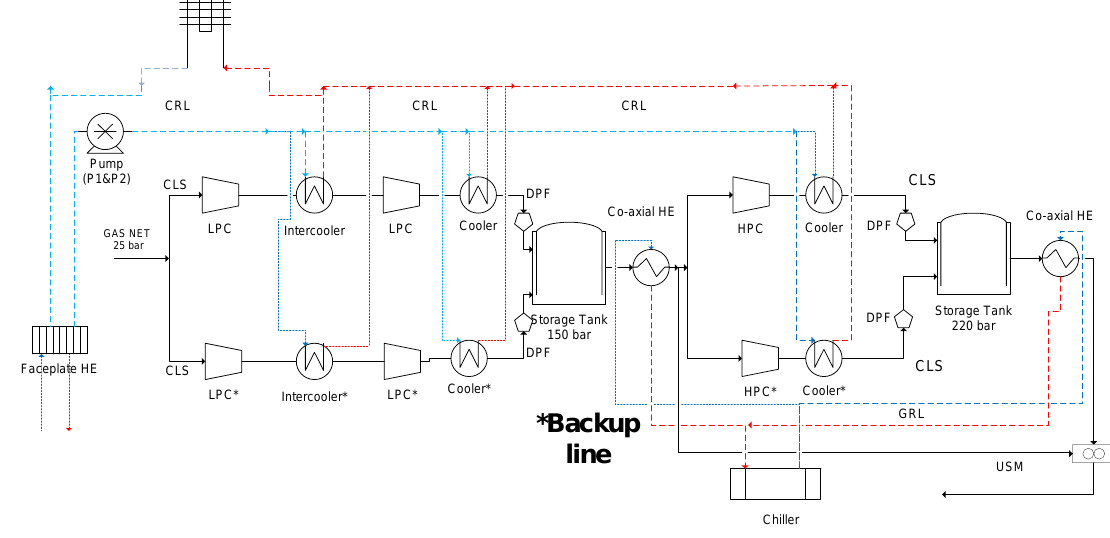
Figure 7. Refueling station: plant schematic.